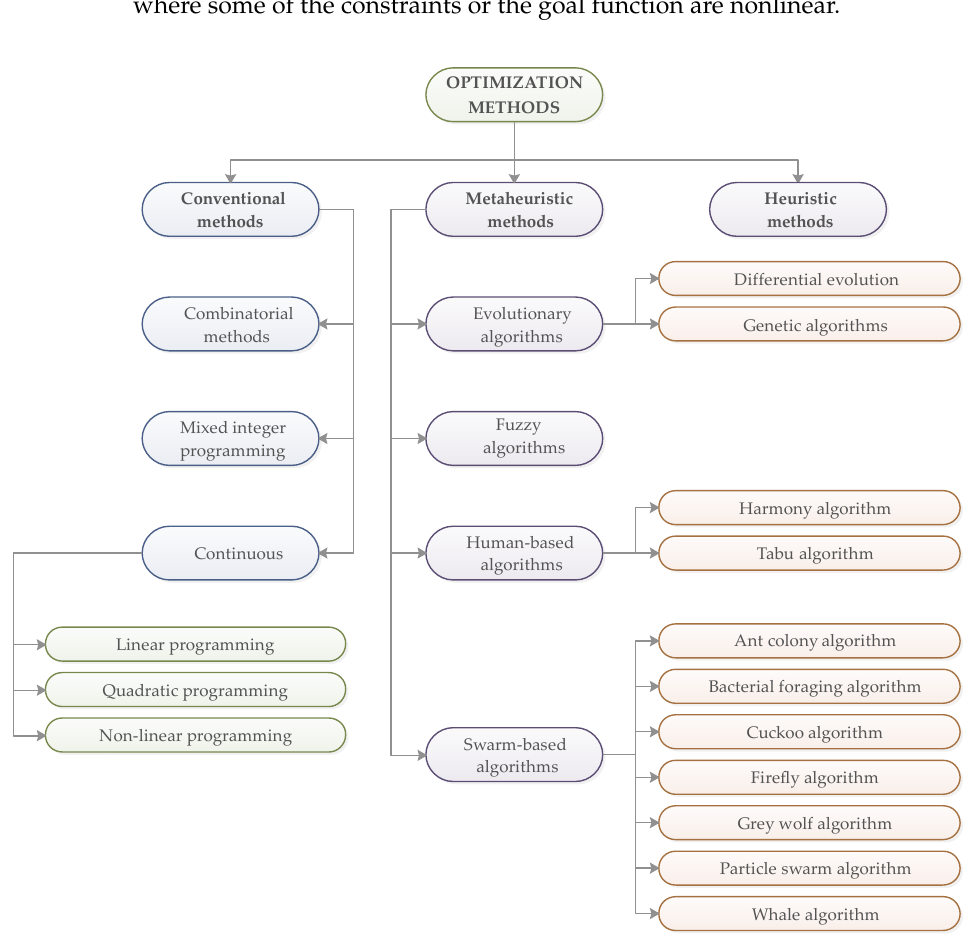
Figure 5. Classification of algorithms used in optimization of APF sizing and placement [91–110].